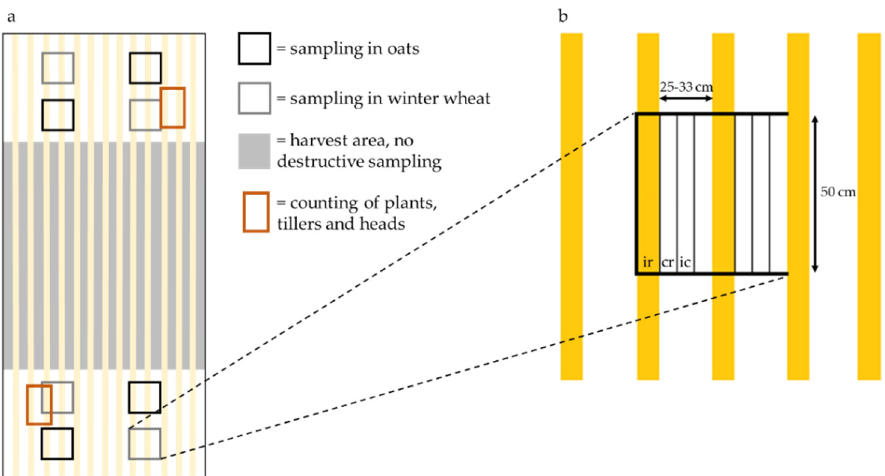
Figure 3. ( a ) Sketch over a plot and where data were collected for the different measurements and crops. For the data collection in oats (black squares) in OG1, only three frames were used. In this case, one frame was used instead of two at one end of the plot and located in the centre of the sampling area. The yellow stripes represent the cereal rows to demonstrate how samples were collected in relation to these. ( b ) Subsections for weed biomass sampling in both oats and winter wheat. Abbreviations: ir = in crop row, cr = close to crop row, ic = inter-row centres.